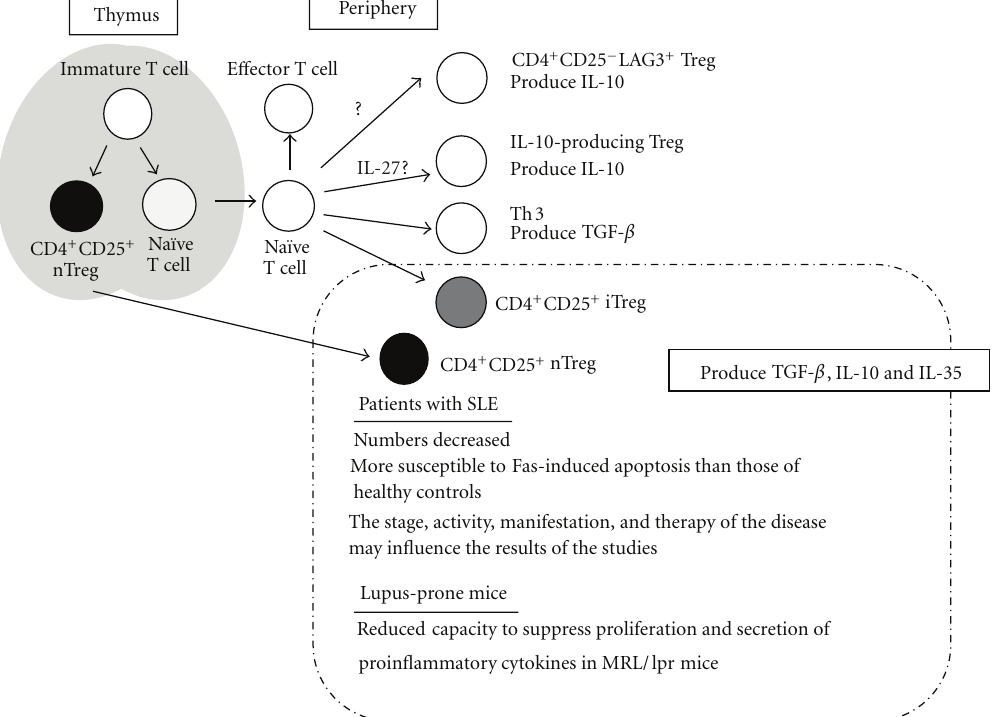
Figure 1: The subsets of regulatory T cells. These Treg cells are candidates which prevent breakdown of self-tolerance and autoimmune